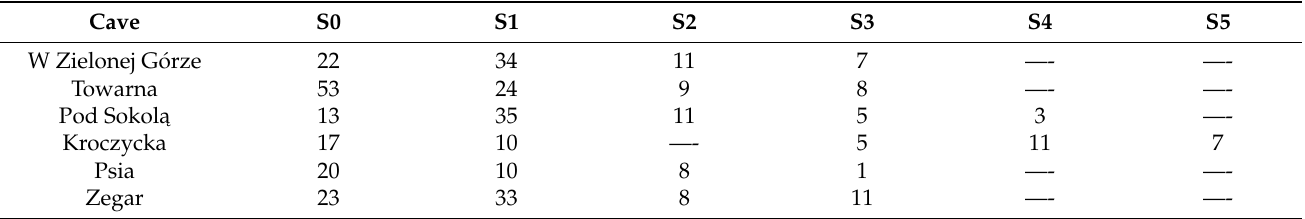
Table 1. Number of species recorded in particular parts of studied caves. S0–S5—sampling sites.